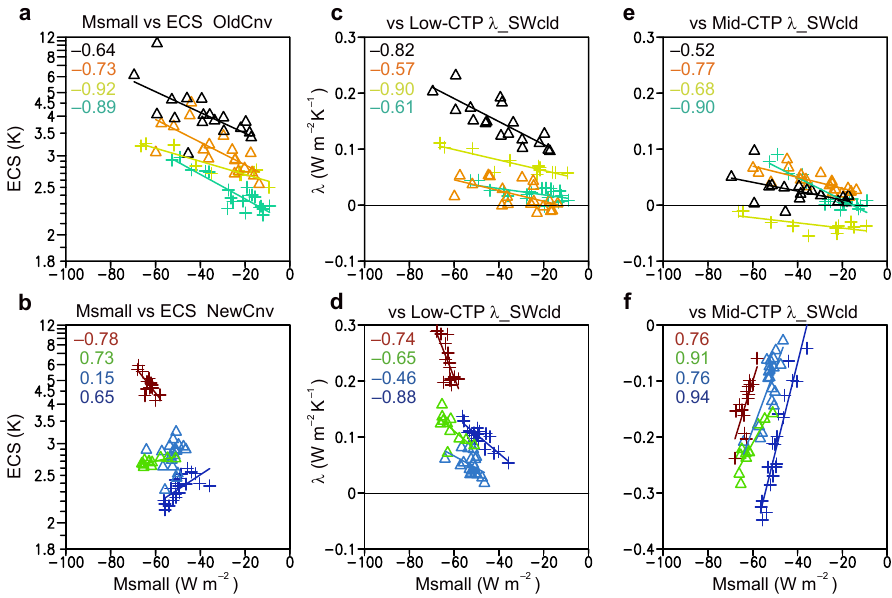
Figure 15. (a) Scatterplot of M small (Wm − 2 ; small-scale mixing) and ECS (K) for ensembles with an old convective scheme (OldCnv) subset. Values at top left in the panels indicate correlation coefficients of the individual perturbed physics ensembles (PPEs); (c) M small and shortwave cloud feedback parameter λ S Wcld (Wm − 2 K − 1 ) in bins of 1.3–23 for τ and 800–1000hPa for cloud-top pressure (CTP); and (e) M small and λ S Wcld in bins of 23–60 for τ and 440–680hPa for CTP. (b) , (d) , and (f) : as in (a) , (c) , and (e) but for ensembles with a new convective scheme (NewCnv) subset. Reprinted from Kamae et al. (2016), ©American Meteorological Society. Used with